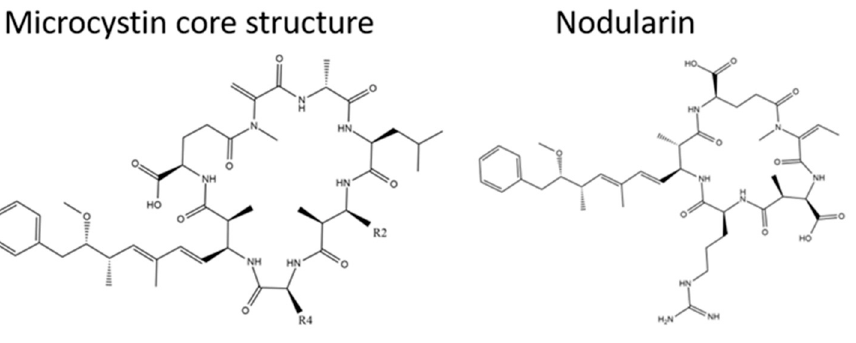
Figure 1. Microcystin core and nodularin structures. For microcystin, the two variable amino acids are annotated as R2 and R4.